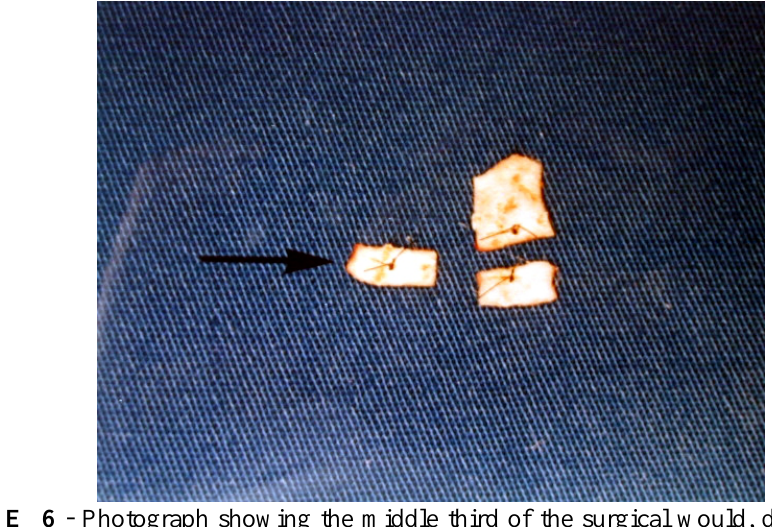
FIGURE 6 - Photograph showing the middle third of the surgical would, dislocated to the left (arrow), which was used for examination under an optical